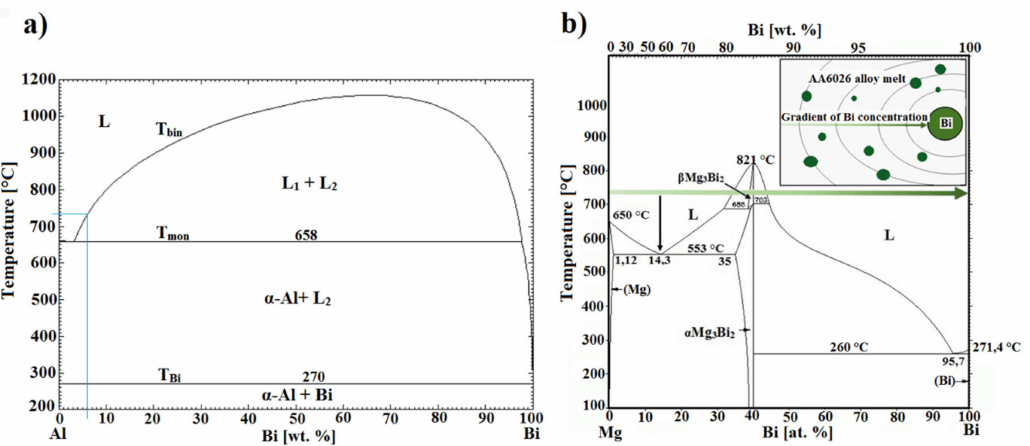
Figure 7. Phase diagrams: ( a ) Al-Bi [10]; ( b ) Mg-Bi (modified from ref. [16]).